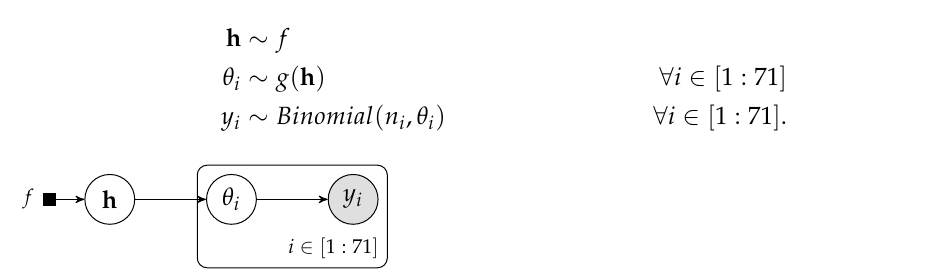
Figure 1. General probabilistic graphical model for the rodents example.